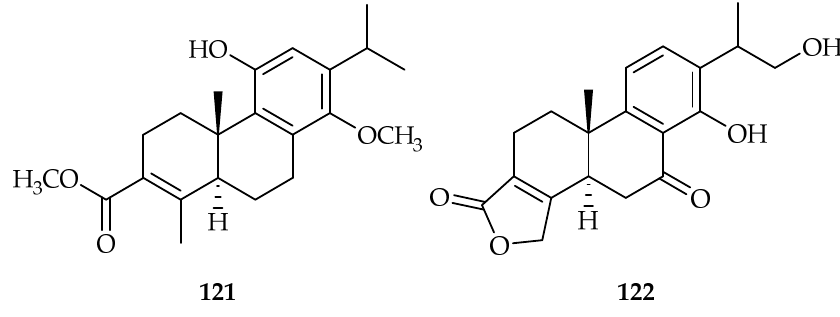
Figure 50. Structures of tripterregeline A 121 [74] and trigohowimine A 122 [75].